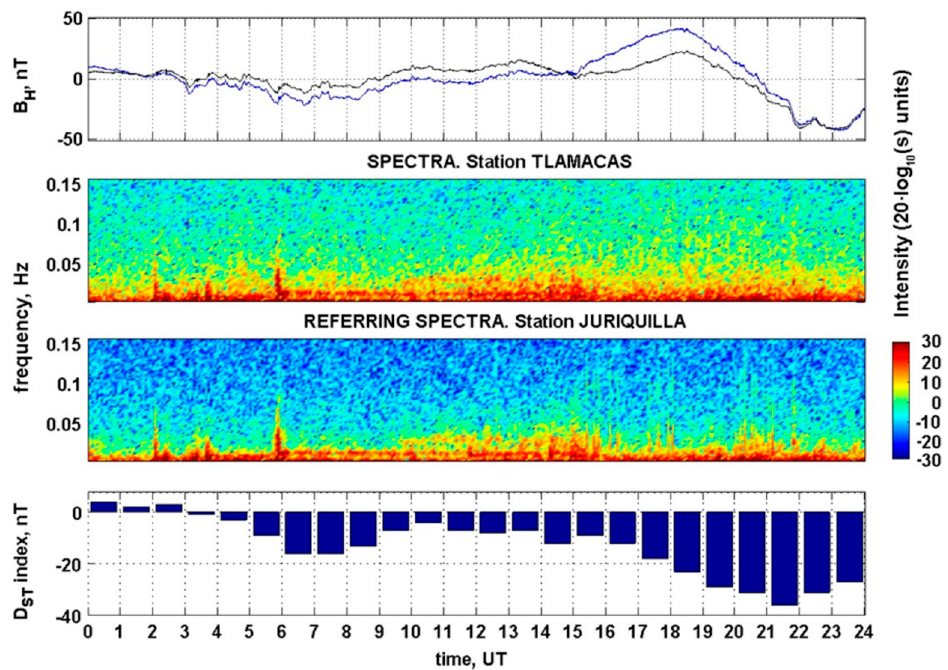
Figure 2. ( top panel ) H — component signals, Tlamacas (blue line) and Juriquilla (black). ( 2nd and 3rd panel ) Tlamacas and reference spectrogram dynamic spectra. ( bo tt om panel ) Disturbance Storm 3rd panel ) Tlamacas and reference spectrogram dynamic spectra. ( bottom panel ) Disturbance Storm Time (Dst) index of geomagnetic activity. Time (Dst) index of geomagnetic